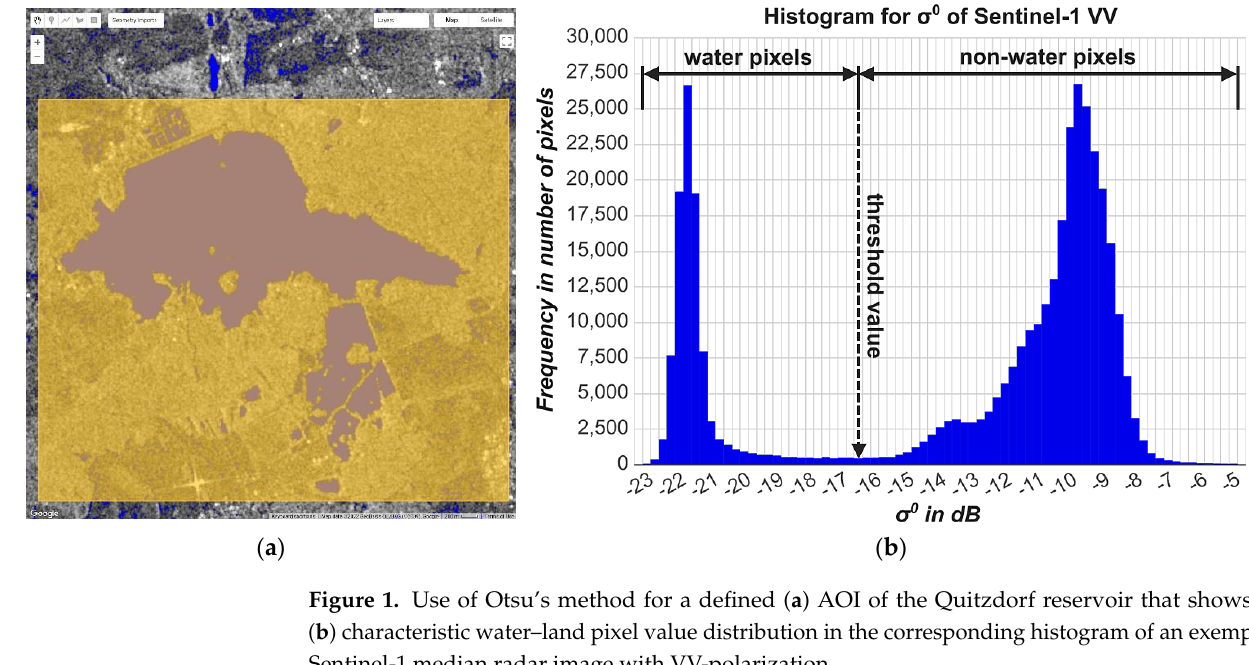
Figure 1. Use of Otsu ’ s method for a defined ( a ) AOI of the Quitzdorf reservoir that shows the ( b ) characteristic water – land pixel value distribution in the corresponding histogram of an exemplary Sentinel-1 median radar image with VV-polarization.